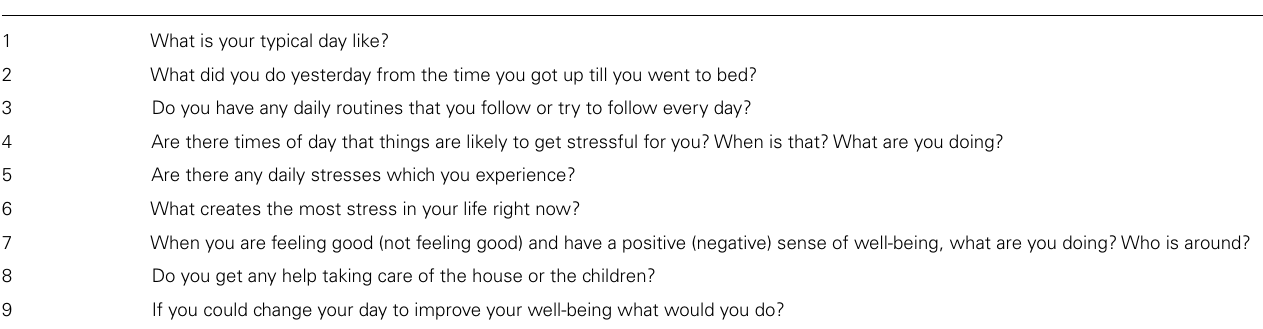
Table 1 | Questions used from interview